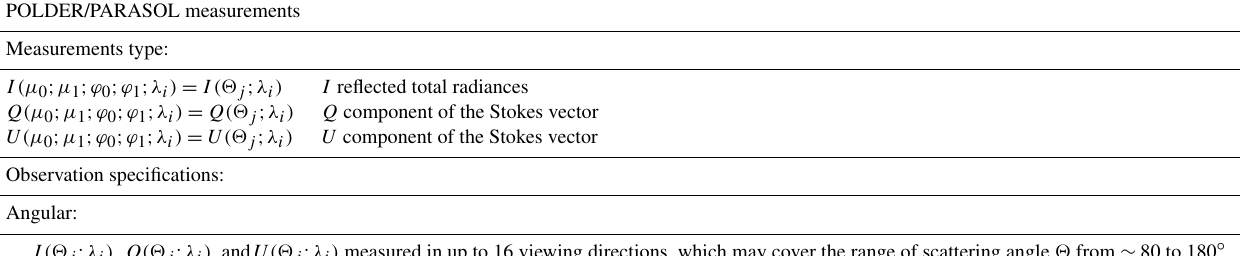
Table 1. List of measured and retrieved characteristic considered in POLDER/GRASP with the aerosol component mixing model. µ 0 = cos (ϑ 0 ) depends on the solar zenith angle ϑ 0 , and µ 1 = cos (ϑ 1 ) depends on the observation zenith angle ϑ 1 . ϕ 0 and ϕ 1 represent the solar and observation azimuth